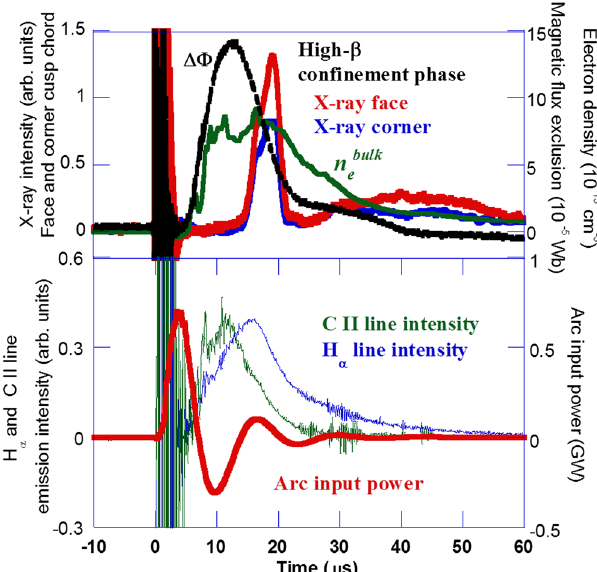
FIG. 4. Time-resolved experimental results showing enhanced high-energy electron confinement of high- β plasma state in a magnetic cusp